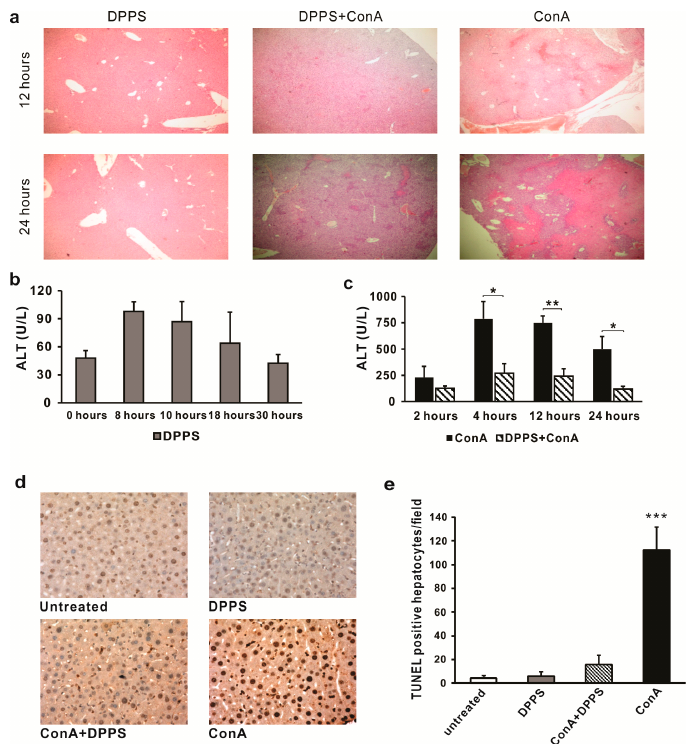
Figure 3. Pretreatment with DPPS attenuates markers of liver damage in ConA-induced acute hepatitis. DPPS pretreatment shows hepatoprotective effects in ConA-induced hepatitis. C57BL/6 mice were intravenously injected with 12.5 mg/kg of Concanavalin A. DPPS was administered orally (20 μ L of 50% mixture solution), six hours before ConA injection. Livers were analyzed 12 and 24 h after ConA injection. ( a ) Representative H&E staining of paraffin-embedded liver sections, magnification 100×. ( b ) ALT levels determined in the serum 0, 8, 10, 18, and 30 h after oral administration of DPPS. ( c ) Serum levels of ALT determined 2, 4, 12, and 24 h after ConA injection ( n = 7). ( d ) TUNEL staining of liver sections 6 h after ConA injection, magnification 400×. ( e ) Quantitative analysis of cell death rate: TUNEL-positive nuclei (brown) were counted in five random fields, and the data were summarized as the mean number of positive cells+SD (*** p < 0.001; ** p < 0.005; * p < 0.05; two-tailed, unpaired Student’s t -test).